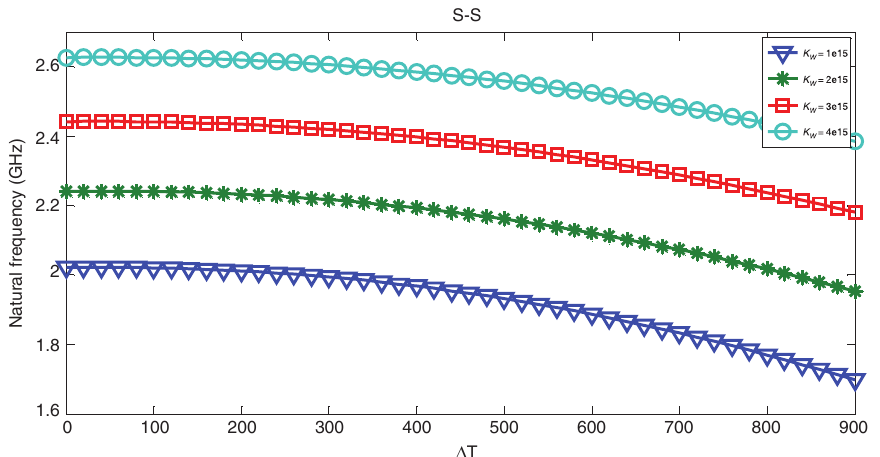
Figure 7: The effect of Winkler stiffness on the natural frequency with simply-simply boundary condition.